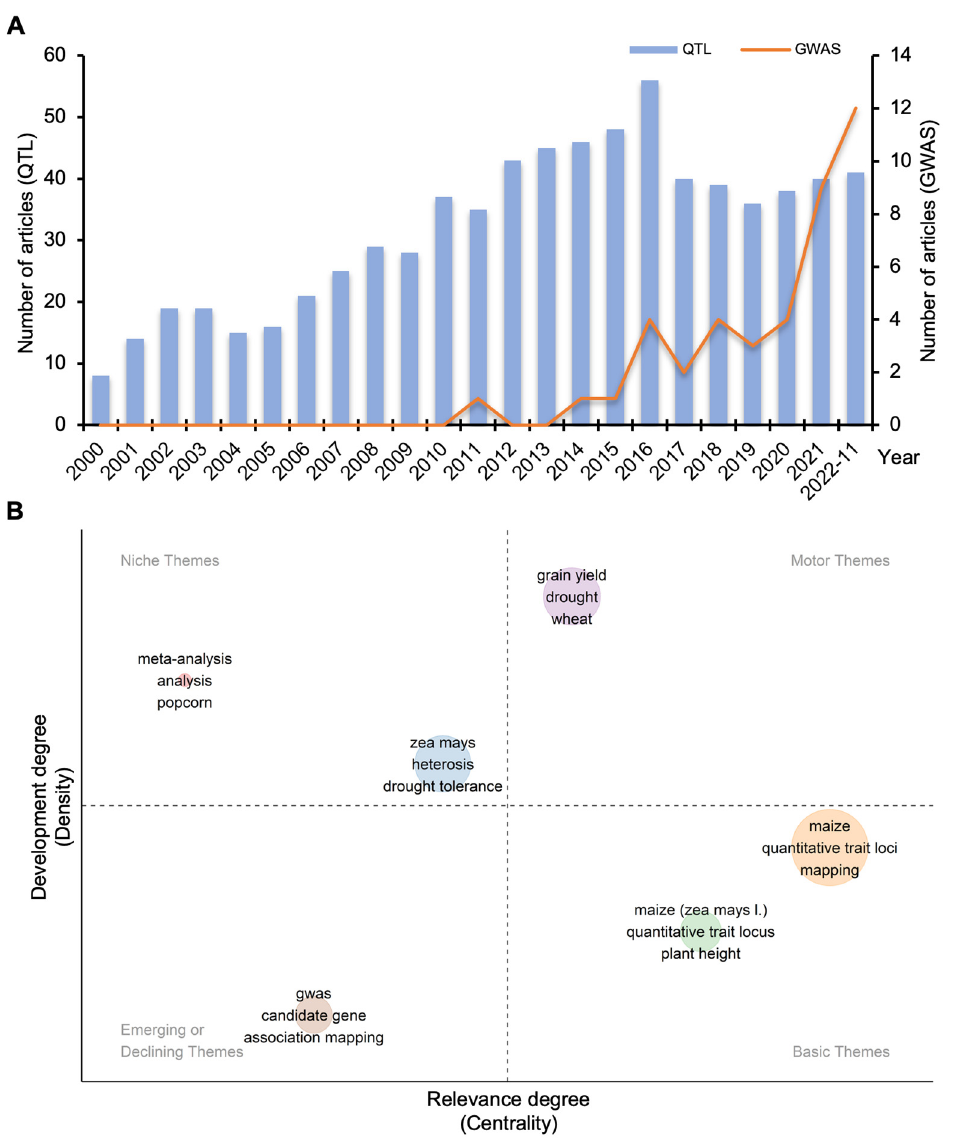
Figure 2. Current situation and future trend of the research of maize kernels. ( A ) The number of GWAS and QTL mapping analysis publications on kernel size from 2000 to November 2022. ( B ) Predicted hot research directions based on known research results.